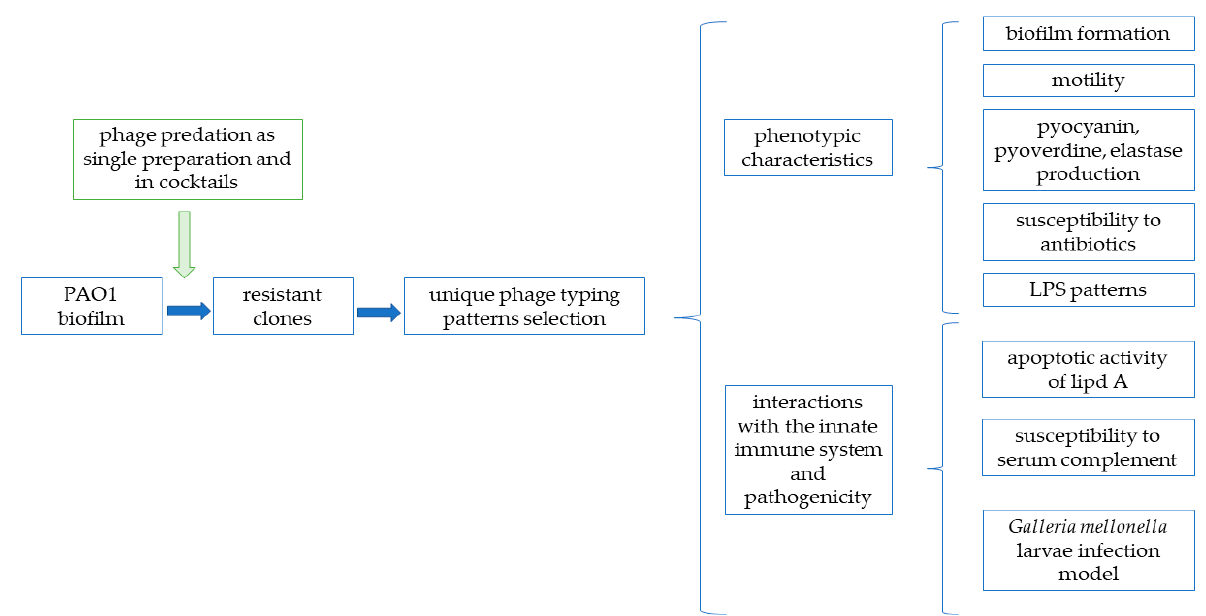
Figure 1. The scheme of the experimental pipeline and methodology used to determine the emergence of phage resistance in a P. aeruginosa PAO1 biofilm population and its impact on bacterial heterogeneity and virulence.